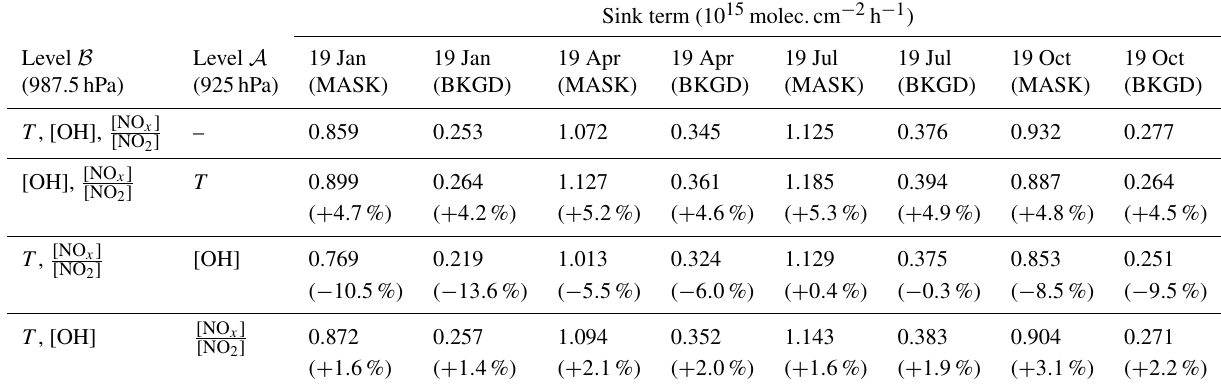
Table 2. Analysis of the effect of a vertical change in the parameters used to estimate the mean sink term in NO x emissions: temperature, hydroxyl radical concentration and NO x : NO 2 concentration ratio. The comparison is conducted between the estimated quantities at level B and level A for mask cells (MASK) and background cells (BKGD) for January, April, October and July 2019. Values within brackets represent the variation from the base case for which all quantities are estimated at level B